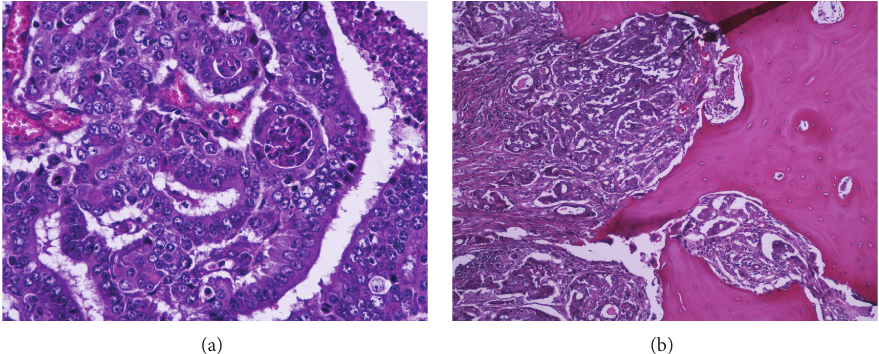
Figure 4: (a) Left ethmoid mass. The nasal adenocarcinoma effaces normal turbinates. The patterns of neoplastic cell distribution varied between tubular (shown) and solid. Hematoxylin and eosin, 400x. (b) Right humerus. Metastatic nasal adenocarcinoma, with tubular pattern, invading cortical bone. Hematoxylin and eosin,